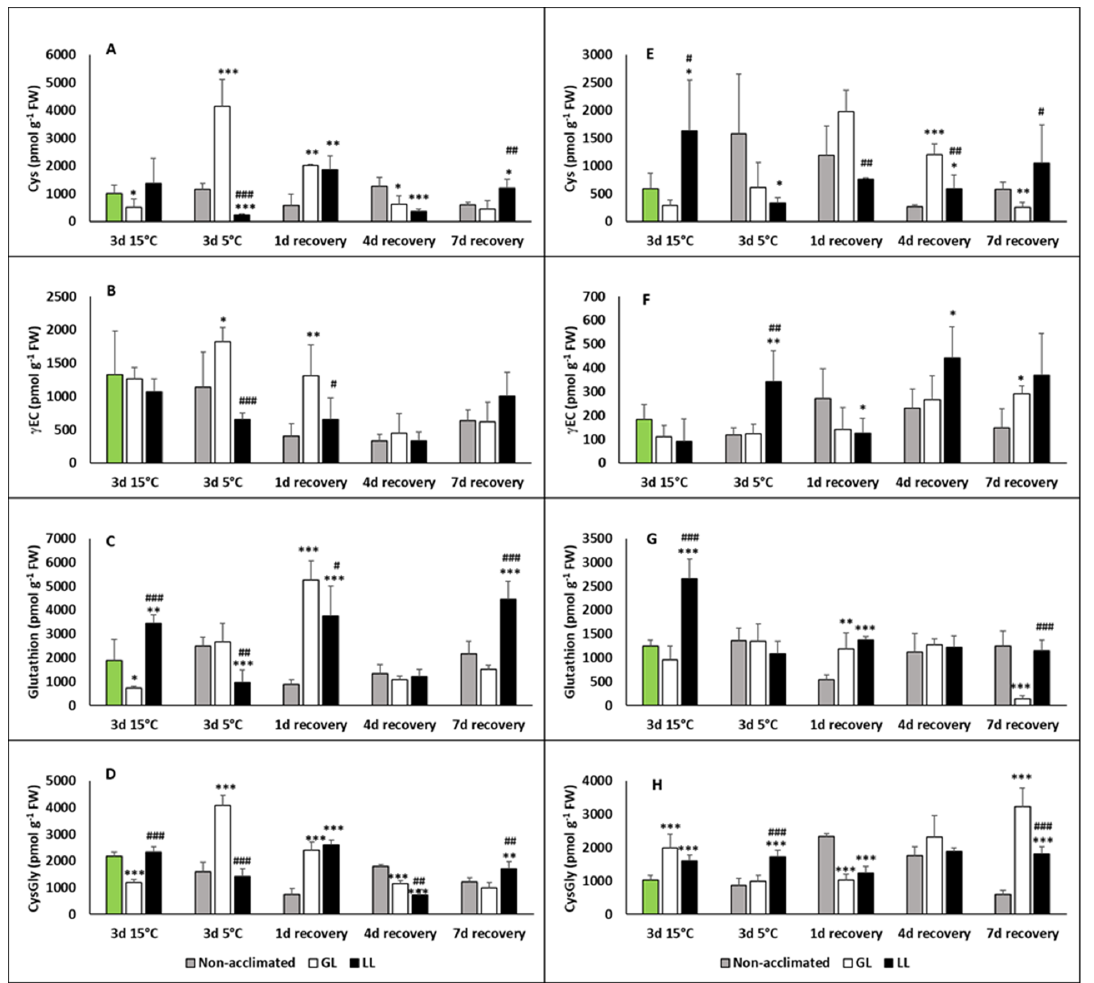
Figure 6. Changes in the thiol contents during cold acclimation (15/13 °C), chilling (5 °C) and recovery in the leaves and roots of young maize plants. Control plants (22/20 °C, 387 µmol m −2 s −1 ). Light intensities during hardening: GL: 387 µmol m −2 s −1 ; LL: 107 µmol m −2 s −1 . *, **, *** significant differences compared to the control plants on the same day at the p < 0.05, 0.01 and 0.001 levels, respectively. # , ## , ### significant differences compared to the GL plants on the same day at the p < 0.05, 0.01 and 0.001 levels, respectively. ( A : cysteine in the leaves; B : γ-glutamyl-cysteine in the leaves; C : gluthathione in the leaves; D : cysteinyl–glycine in the leaves; E : cysteine in the roots; F : γ-glutamyl-cysteine in the roots; G : gluthathione in the roots; H : cysteinyl–glycine in the roots).